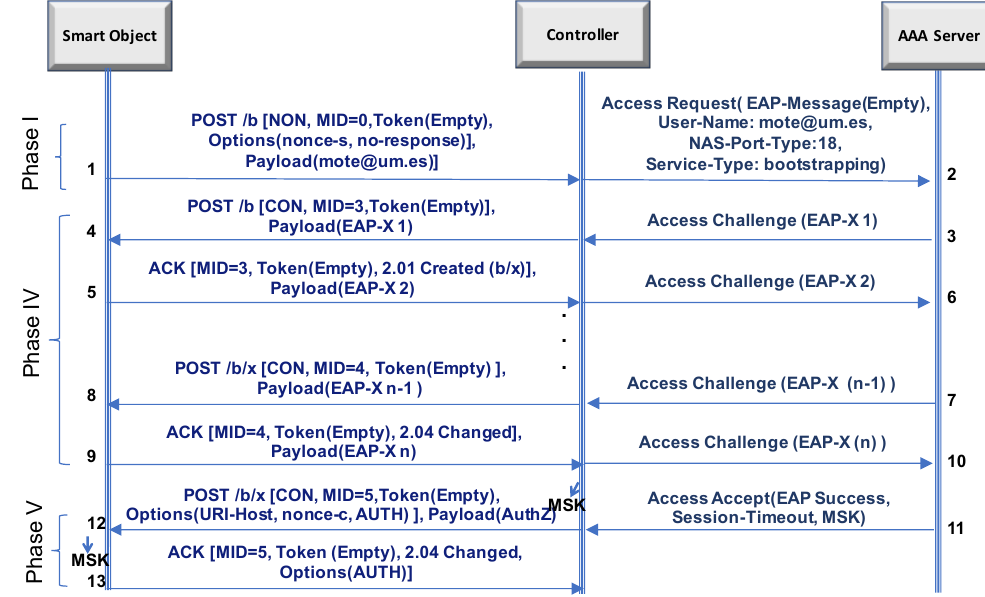
Figure 1. Low-Overhead (LO)-CoAP-EAP bootstrapping service flow using any EAP method X